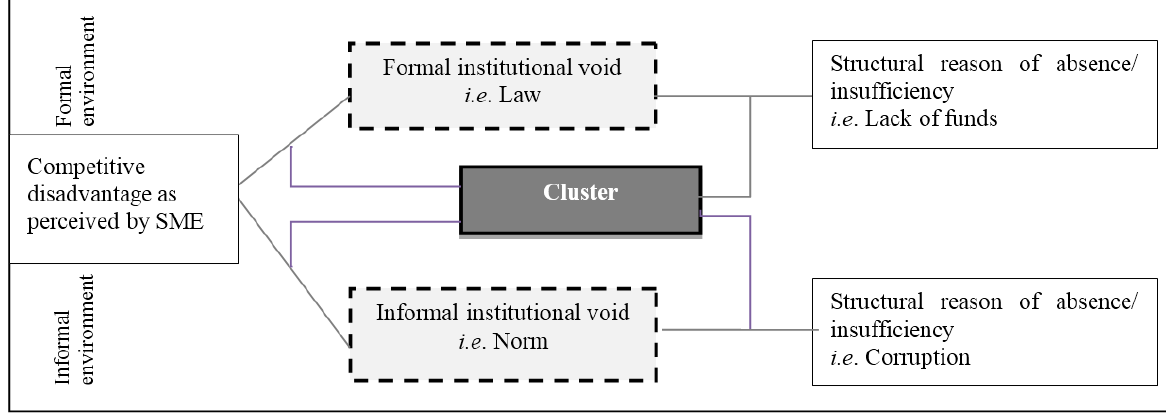
Figure 3 . Research framework (Adapted from